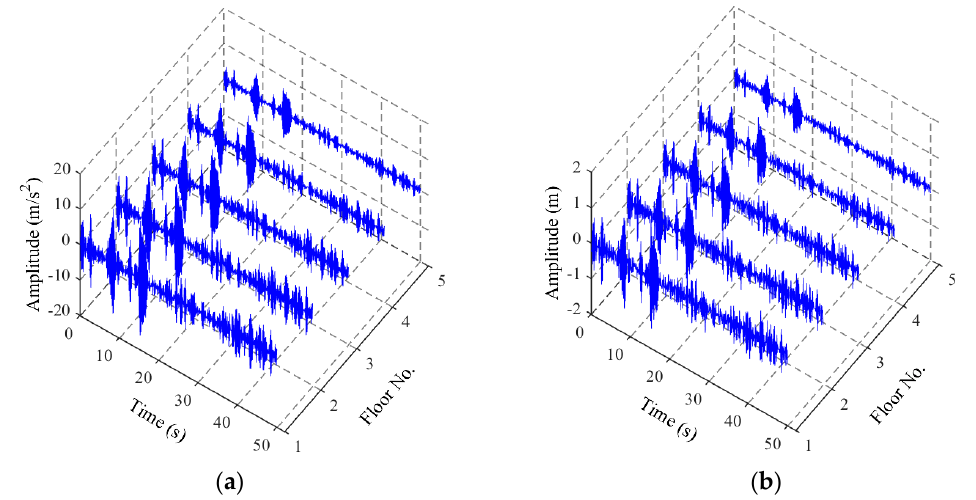
Figure 3. Raw vibration responses in time domain with 20 dB SNR: ( a ) acceleration responses; ( b ) displacement responses. Table 1. Condition scenarios of building anomalies due to stiffness reduction.